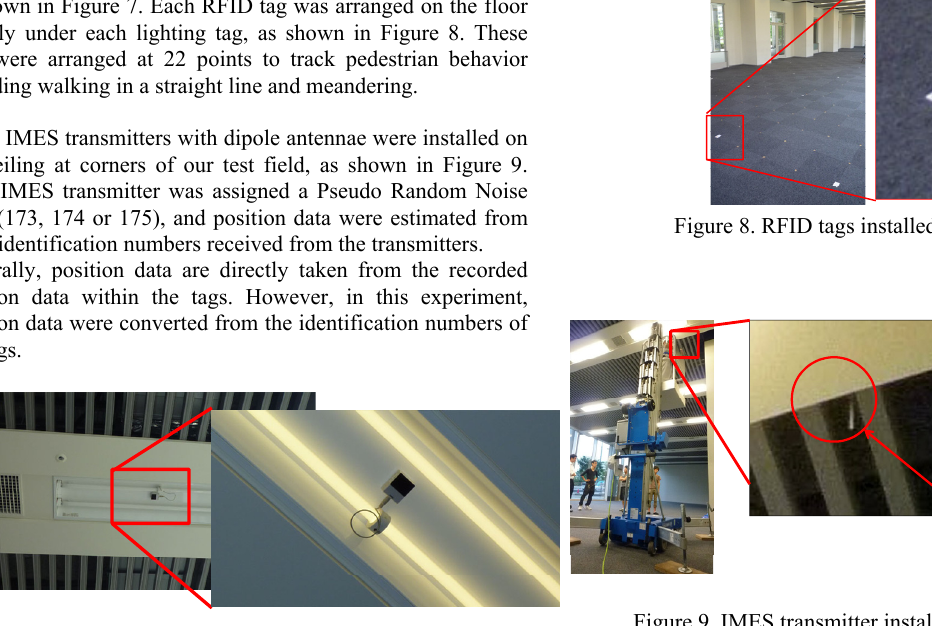
Figure 7. Lighting tags installed on the ceiling